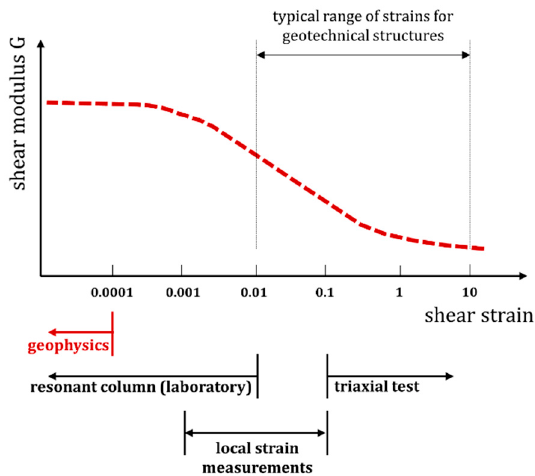
Figure 9. Dependence of the rock mass stiffness on strain level.